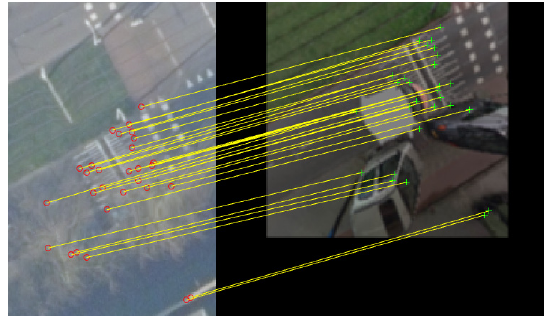
Figure 17 AGAST/SURF matching result of 13th tile with not a single correct